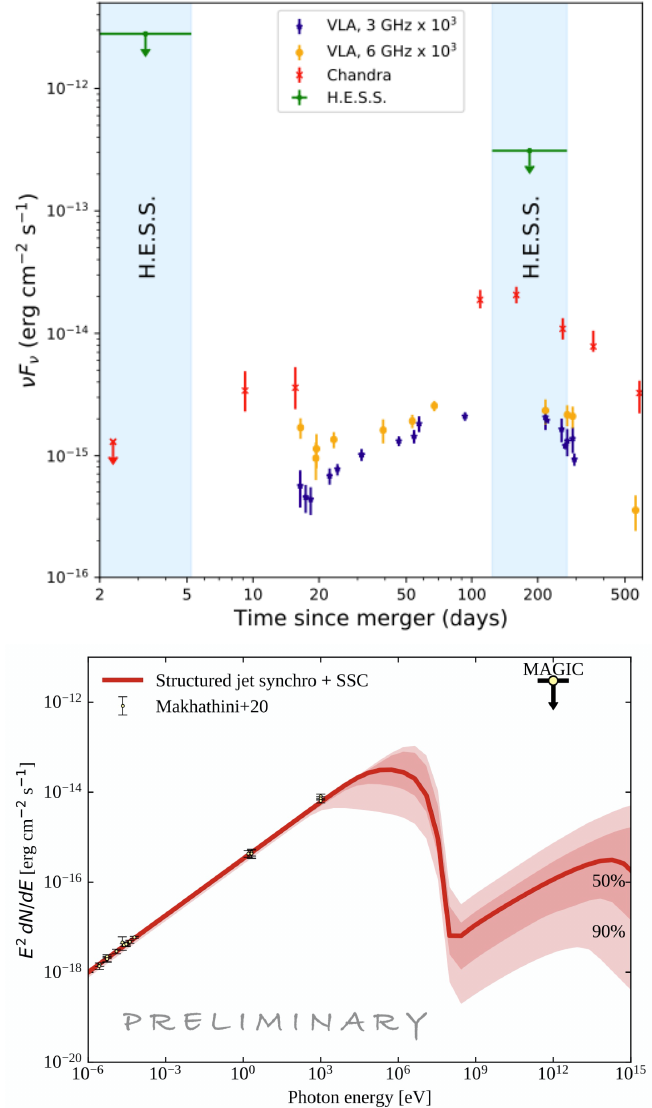
Figure 9. VHE observations of GRB170817A. Top : the H.E.S.S. 1–10TeV energy flux upper limits (green arrows) are compared with VLA radio data at 3GHz (blue stars) and 6GHz (orange circles) and with X-ray data from Chandra (red crosses). Bottom : multi-wavelength SED (radio, optical and X-ray) as computed between 123 and 195 d post-merger. The fit with a synchrotron model and the predicted SSC at 155 days post-merger are shown in red. The MAGIC upper limit is shown by a yellow circle. From